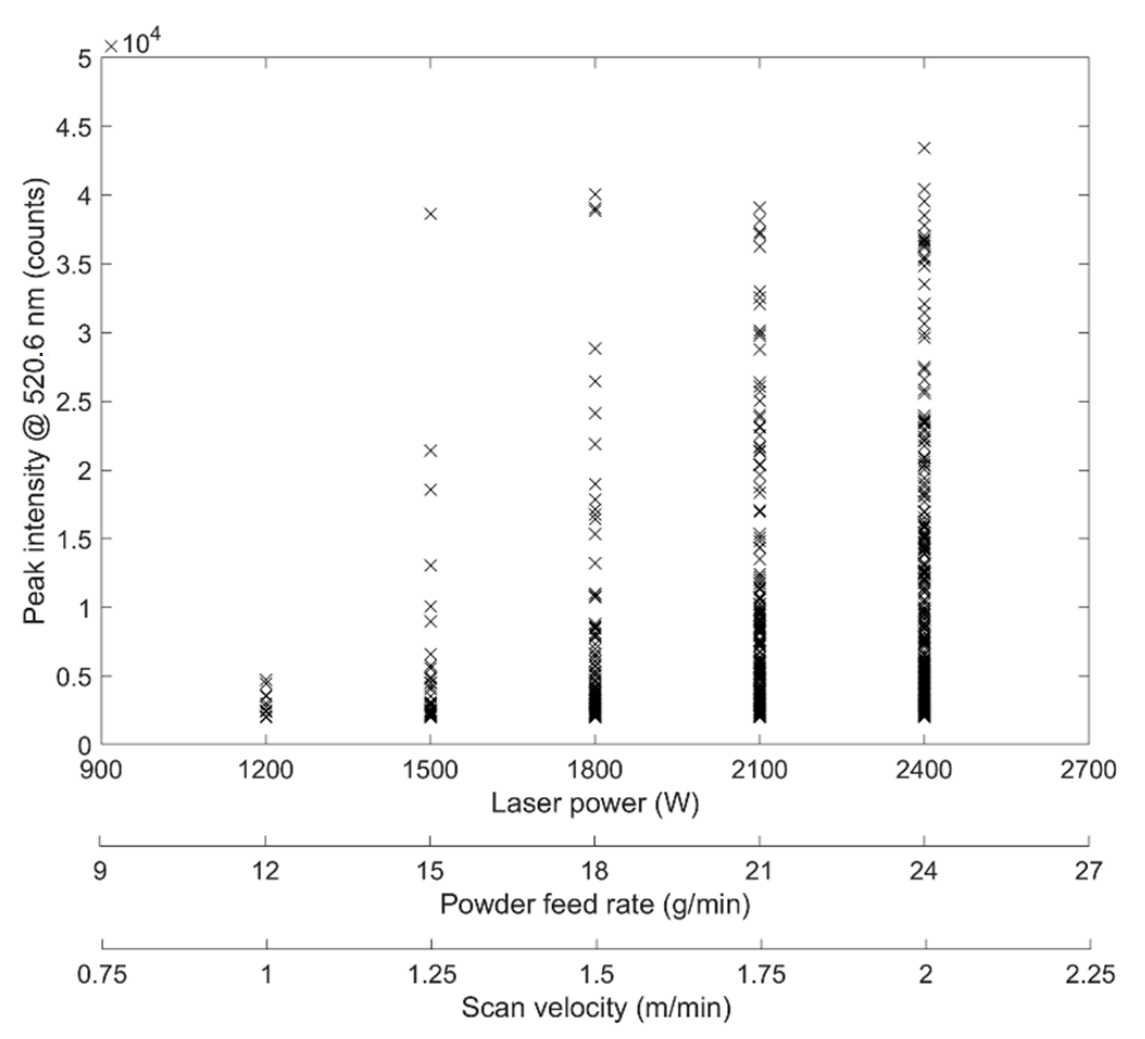
Figure 7. Peak intensity for Cr I line @ 520.6 nm vs. laser power, powder feed rate, and scan velocity, respectively. Data points are generated from all type A spectra of a single deposition track.